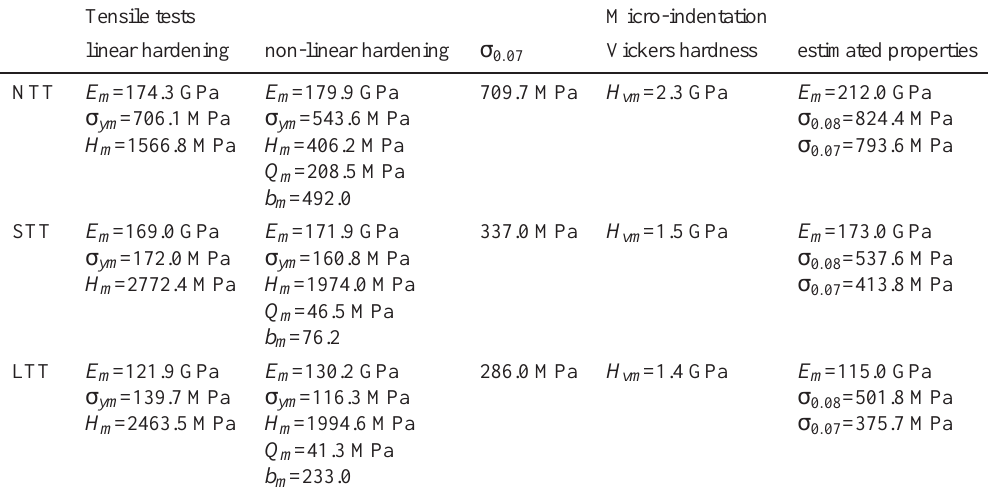
Table 1. Influence of the thermal treatment on the mechanical properties of the Inconel R (cid:13) 600 identified from both the tensile and the micro-indentation